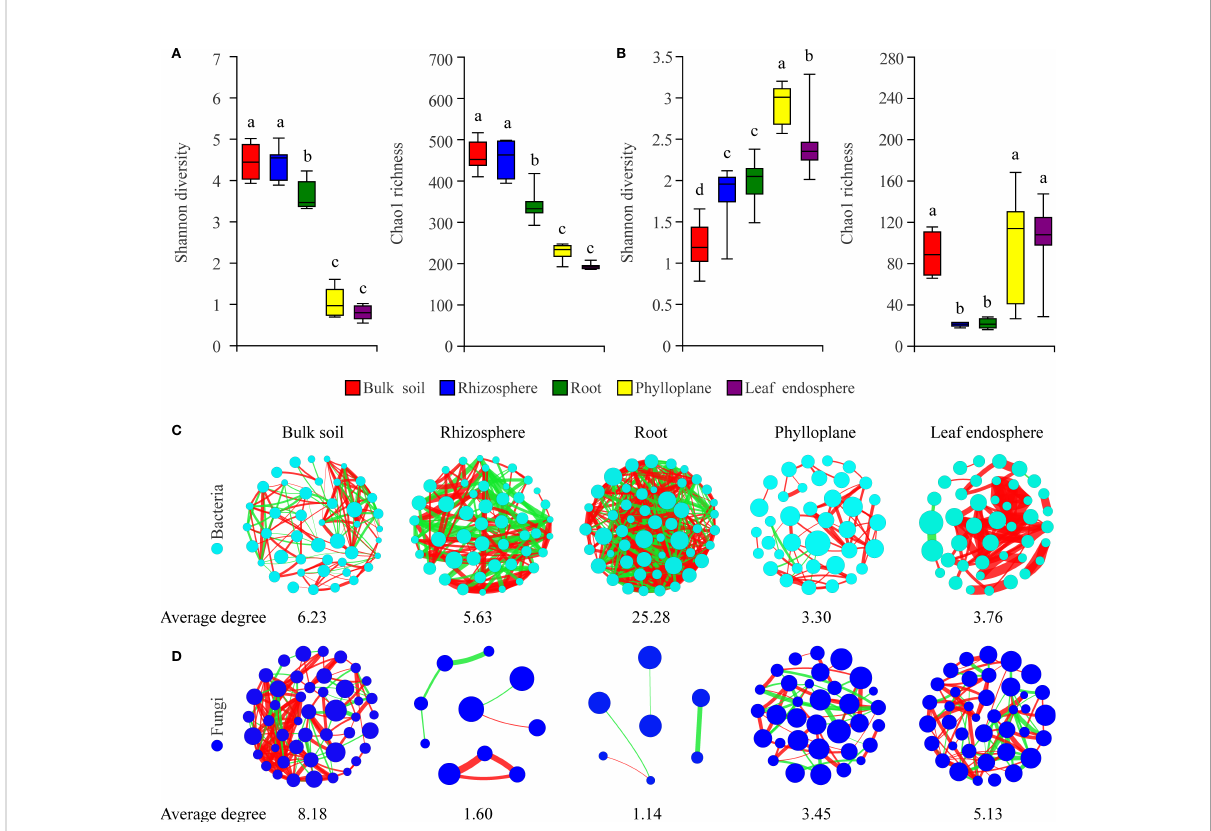
FIGURE 3 Compartment niches have a strongeffectonmicrobial diversity and network complexity. (A, C) Bacterial diversity and co-occurrence networksalong the soil – plant continuum based onallsamples, respectively. (B, D) Fungal diversity and co-occurrencenetworks alongthe soil – plant continuum based onallsamples, respectively. Different lettersabove the box plots indicate signi fi cant differences ( P < 0.05). Averagedegree indicates the degree of network complexity among the microorganismsin the compartment niches. The size ofnodes represents the species abundance. The color ofthe line indicates a positive (red)or negative (green) correlation. The thickness ofthe line indicates the magnitude of the correlation coef fi